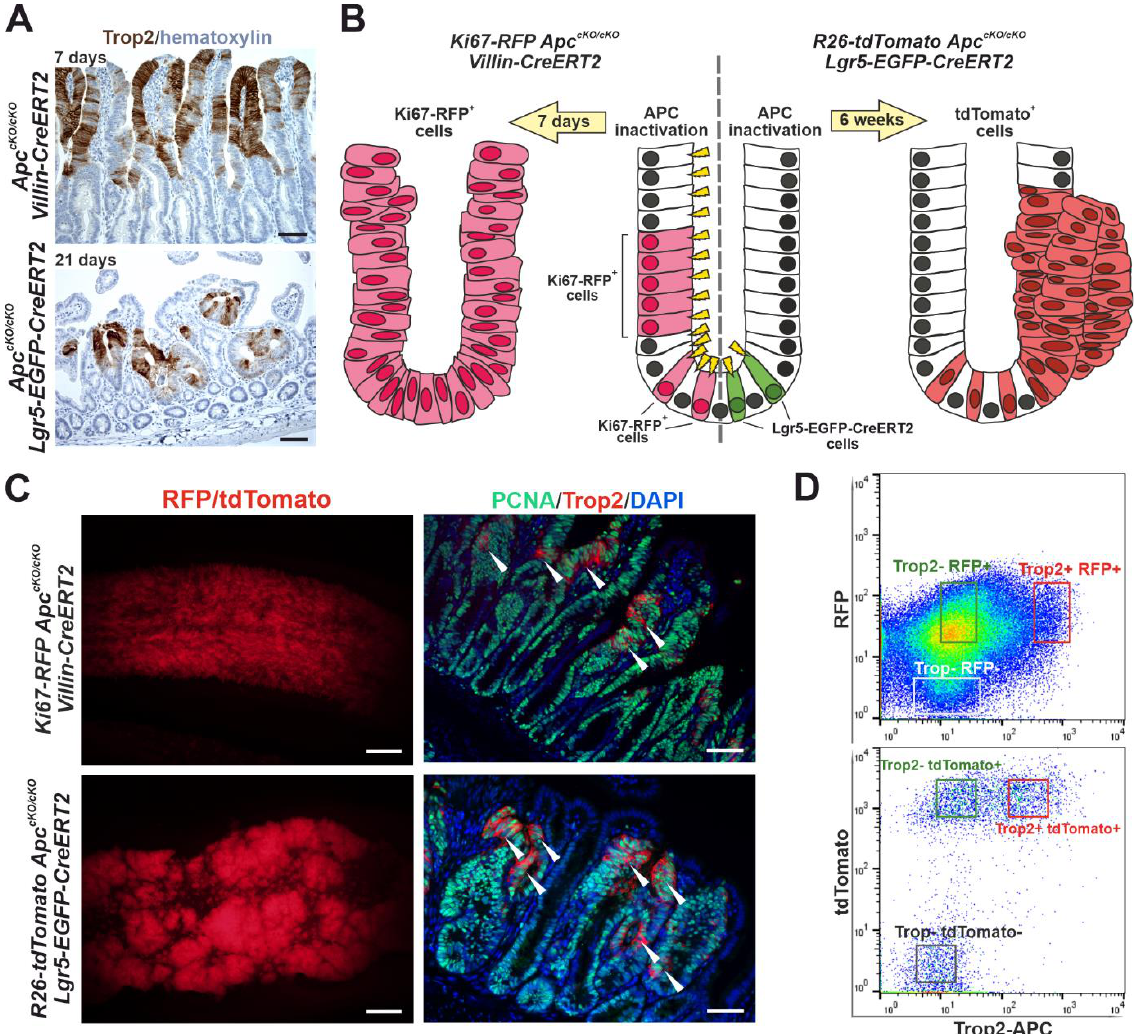
Figure 4. Analysis of Trop2 expression in two mouse models of intestinal tumorigenesis. ( A ) Im- munohistochemical detection of Trop2 in the indicated mouse strains 7 ( upper image) or 21 ( bottom image) days after tamoxifen administration. Specimens were counterstained by hematoxylin; scale bar: 100 µm. ( B ) Schematic diagram of the experimental setup for tumor cell isolation. The middle part of the diagram shows a crypt with the dividing cells (these cells produce the Ki67-RFP fusion protein) and stem cells expressing EGFP and CreERT2 recombinase; cells containing active (nuclear) Cre recombinase (after tamoxifen administration) are labeled by yellow arrowheads. The left and right parts of the diagram depict neoplastic intestinal lesions (marked by red fluorescence) that developed after Apc inactivation with the indicated Cre driver. ( C ) Stereomicroscopic images of native RFP/tdTomato fluorescence ( left ) and immunodetection of PCNA- and Trop2-positive (white arrowheads; right ) cells in the middle part of the small intestine 7 days ( top image) and 6 weeks ( bottom image) after Apc inactivation. The specimens were counterstained with 4 (cid:48) ,6-diamidine-2 (cid:48) - phenylindole dihydrochloride (DAPI; nuclear blue florescent signal). ( D ) Sorting of cell populations used for expression profiling. Scale bars: 2 mm ( left panel) and 100 µ m ( middle